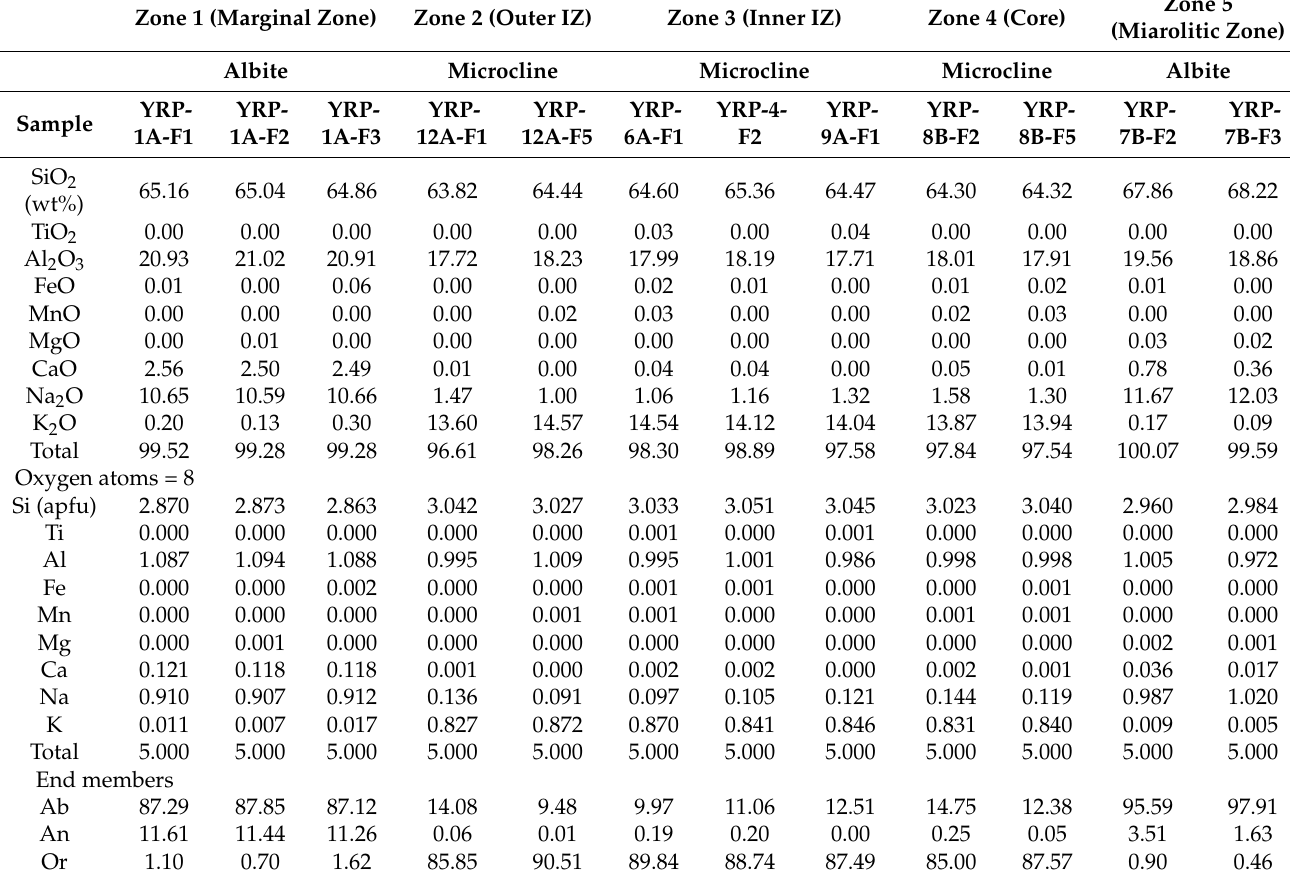
Table 3. The representative EPMA major element composition of alkali feldspar from the Yamrang Pegmatite, Ikhabu Pegmatite Field (IPF), Eastern Nepal.